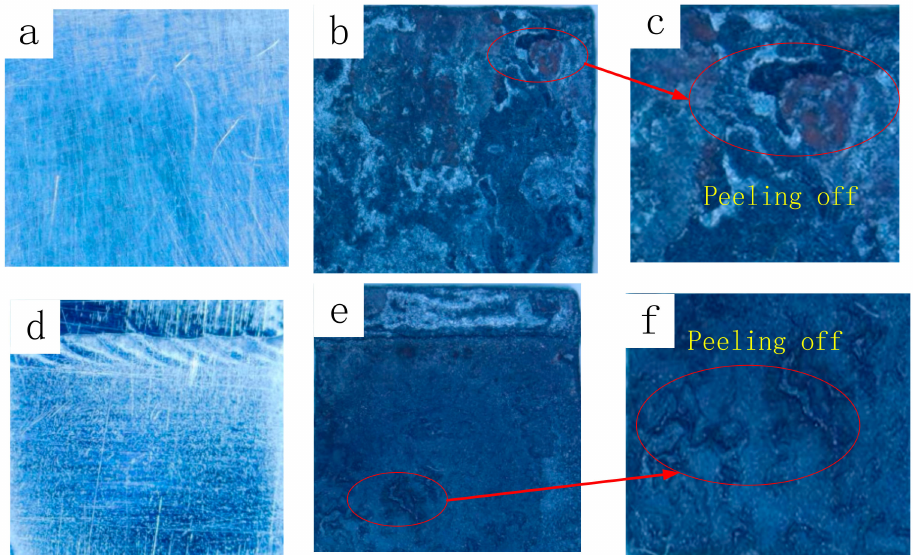
Figure 12. The result of thermal shock test ( a ) the top of layer before thermal shock test, ( b ) and ( c ) the top of layer after thermal shock test; ( d ) the side of layer before thermal shock test, ( e ) and ( f ) the side of layer after thermal shock